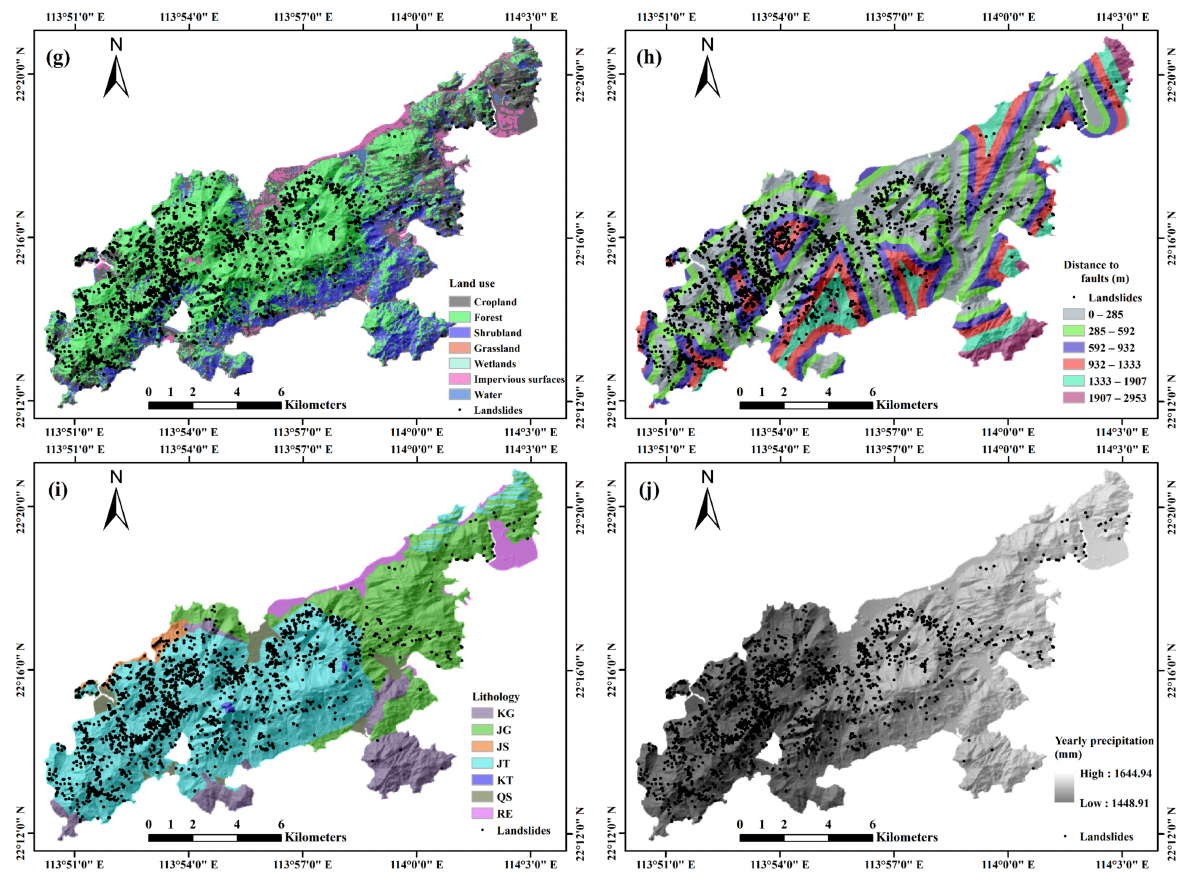
Figure A1. Maps showing landslide predisposing factors in Lantau Island: ( a ) elevation, ( b ) slope aspect, ( c ) slope angle, ( d ) TRI, ( e ) TWI, ( f ) NDVI, ( g ) land use, ( h ) distance to faults, ( i ) lithology, and ( j ) yearly precipitation.